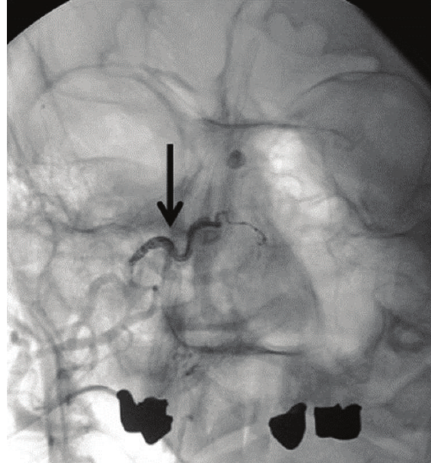
Figure 3: Sinonasal hemangiopericytoma after embolisation with Onyx. Right maxillary artery embolised with Onyx ( →